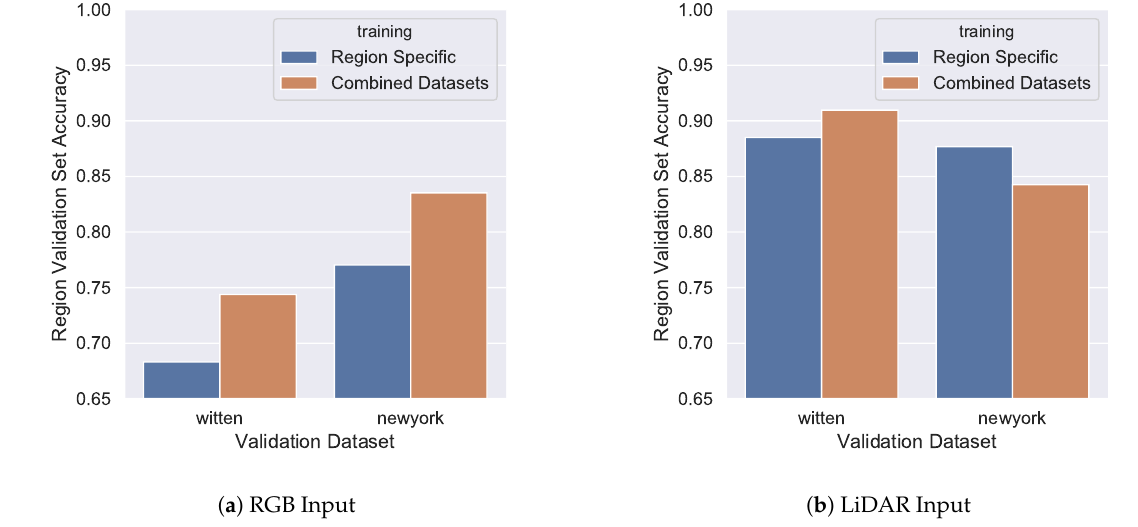
Figure 11. Comparison between region-specific and combined training datasets. Results labeled “combined dataset” are trained on images from both Witten and Manhattan. Validation set accuracy on the vertical axis is specific to the region indicated on the horizontal axis. ( a ) RGB (satellite) image input and ( b ) LiDAR image